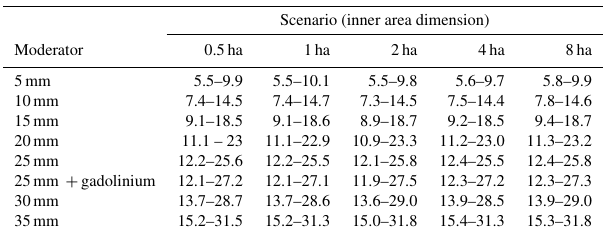
Table A1. Minimum and maximum percentage of non-albedo neu- trons detected with different moderators and different